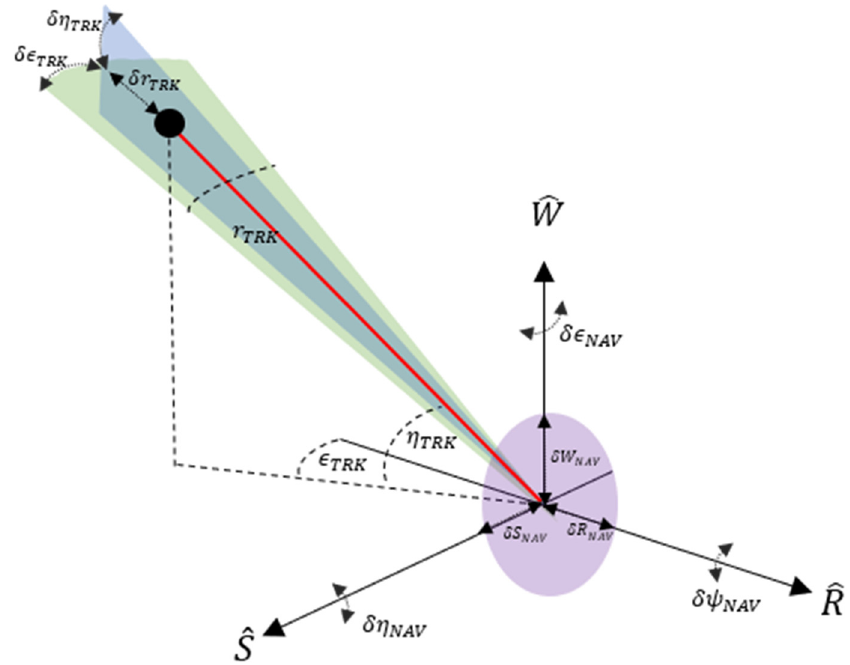
Figure 6. Space-based observation geometry and measurement deviations in RSW frame.